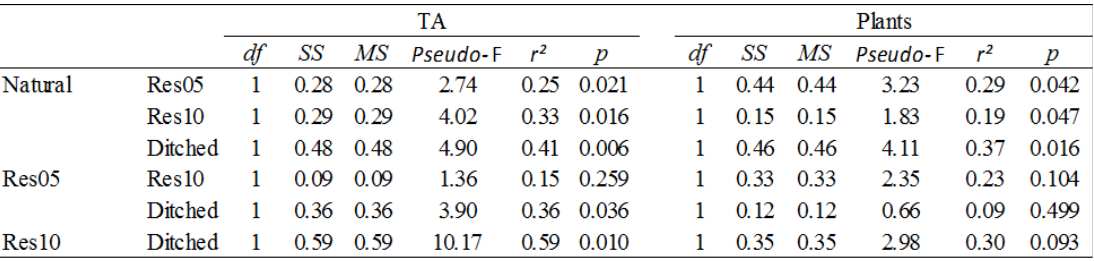
Table 3. TA average relative abundances in percentage and standard deviations for each management